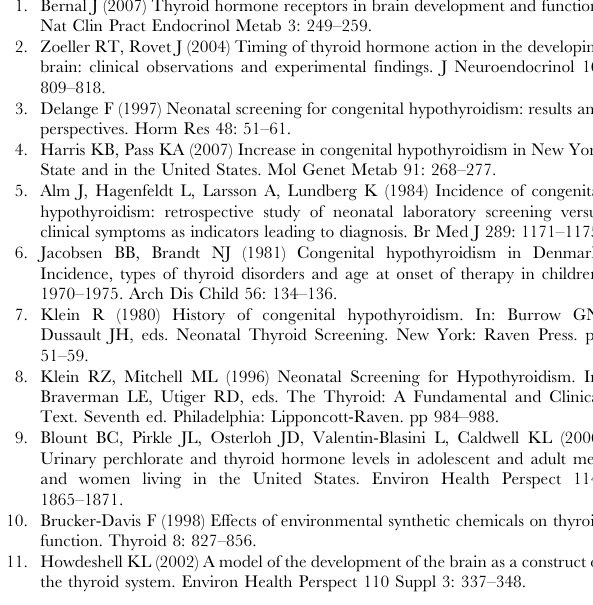
Table S3 Serum T4 of mouse pups from in vivo TH